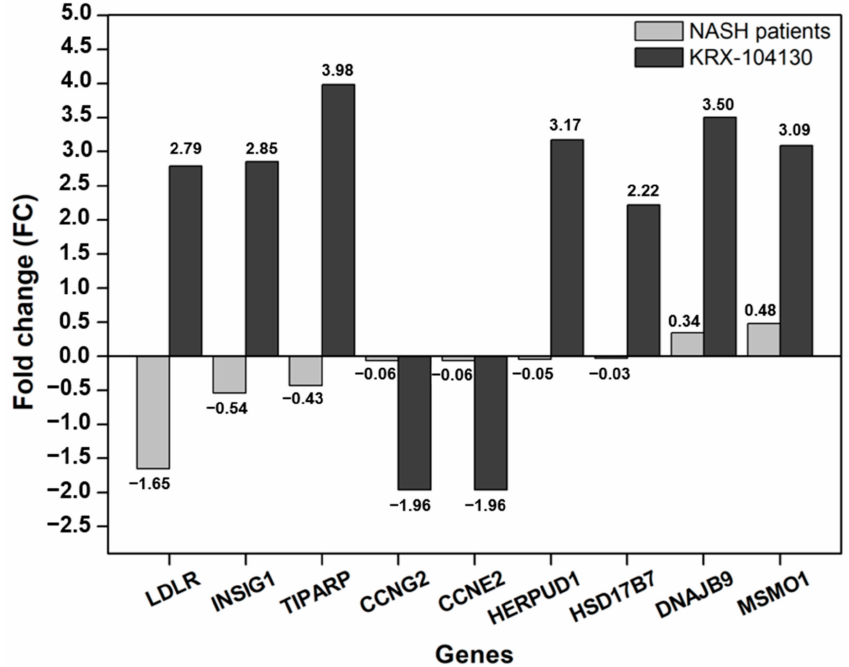
Figure 6. Comparison gene expression of selected common genes with NASH patient group. The X -axis represents the common genes for cell lines, the Y -axis represents the fold change. The gray and dark gray bars represent the fold change in the NASH patient group and the KRX-104130, respectively. From the left, the genes were sorted in ascending order by the fold change of the NASH patients